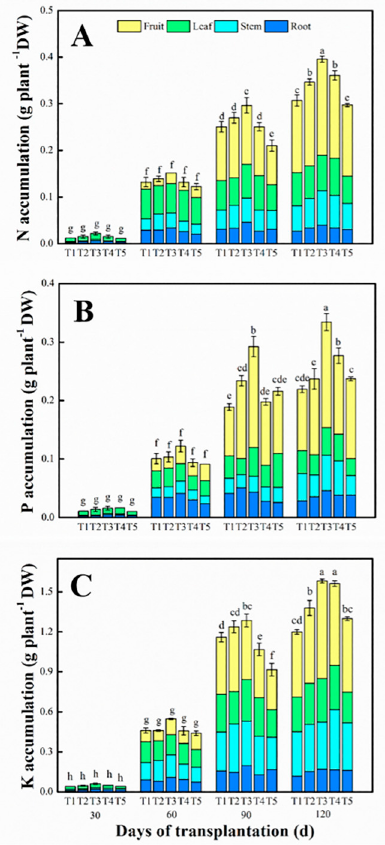
Figure 3. Total N ( A ), P ( B ), and K ( C ) accumulation in the root, stem, leaf and fruit of pepper plants as affected by different NH 4+ :NO 3 − ratios. Vertical bars represent mean ± SE from three independent replicates and the different letters denote significant differences ( p < 0.05). The five treatments were defined in Figure 1 above.